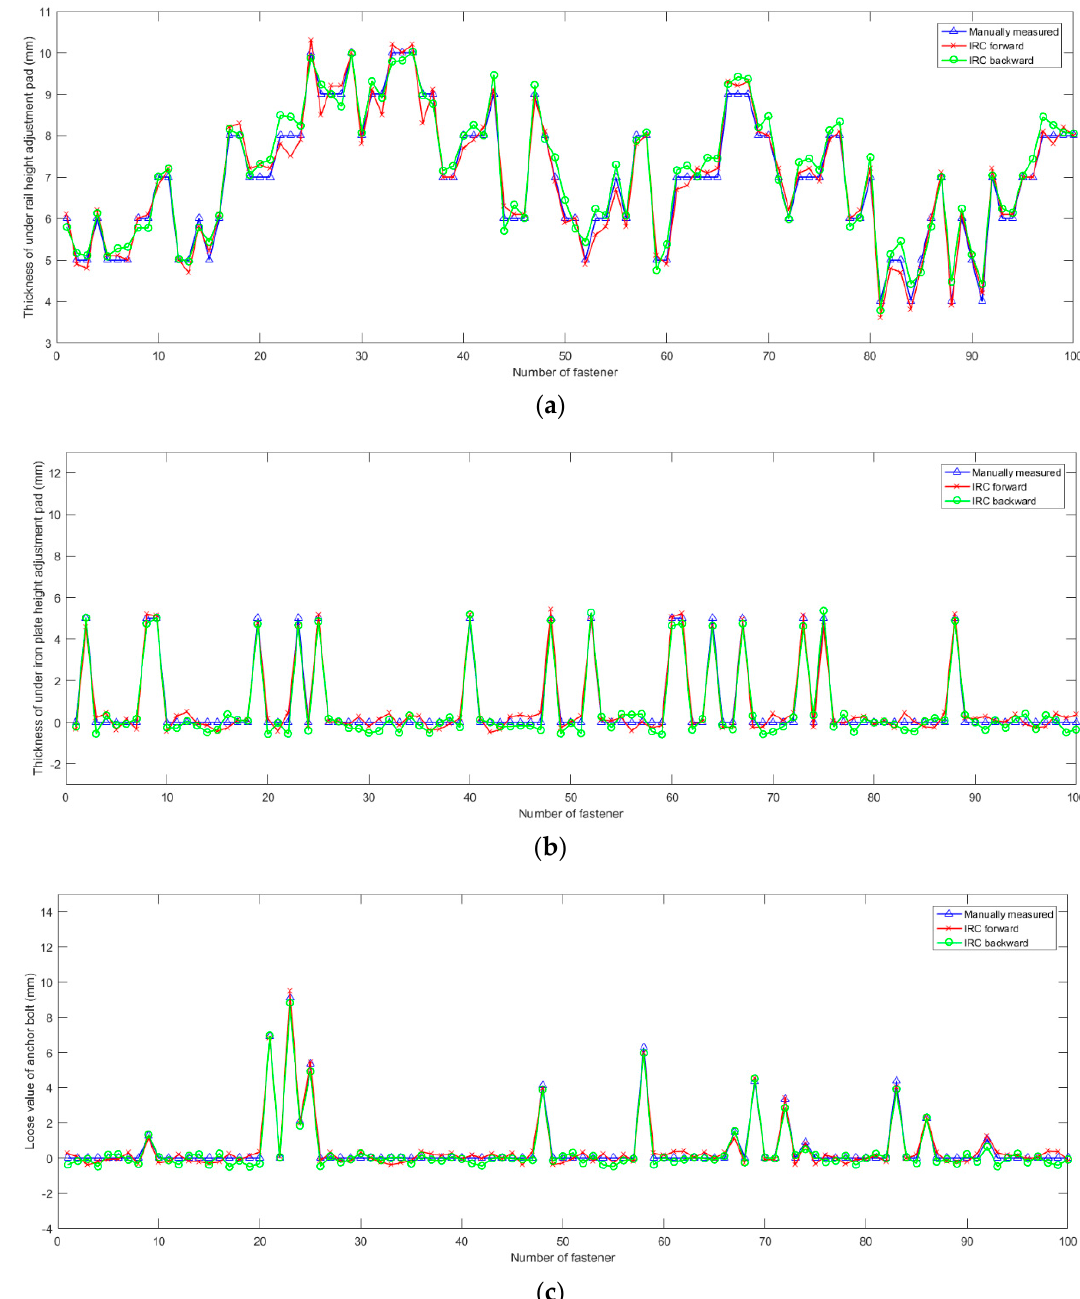
Figure 15. Geometric parameter results by manual measurements, IRC forward, and IRC backward. ( a ) Thickness of under rail height adjustment pad; ( b ) Thickness of under iron plate height adjustment pad; ( c ) Loose value of anchor bolt.